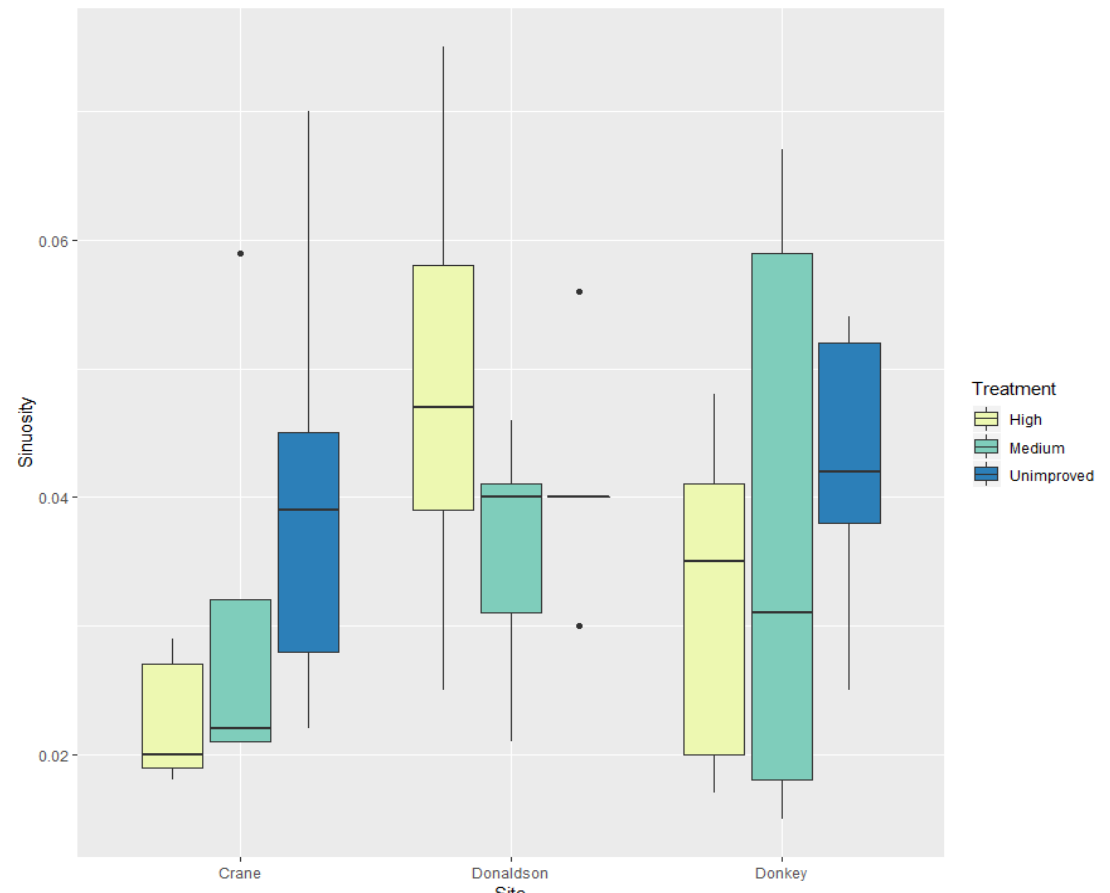
Figure 2. Relativized sinuosity ratings across different sites and genetic gain levels.